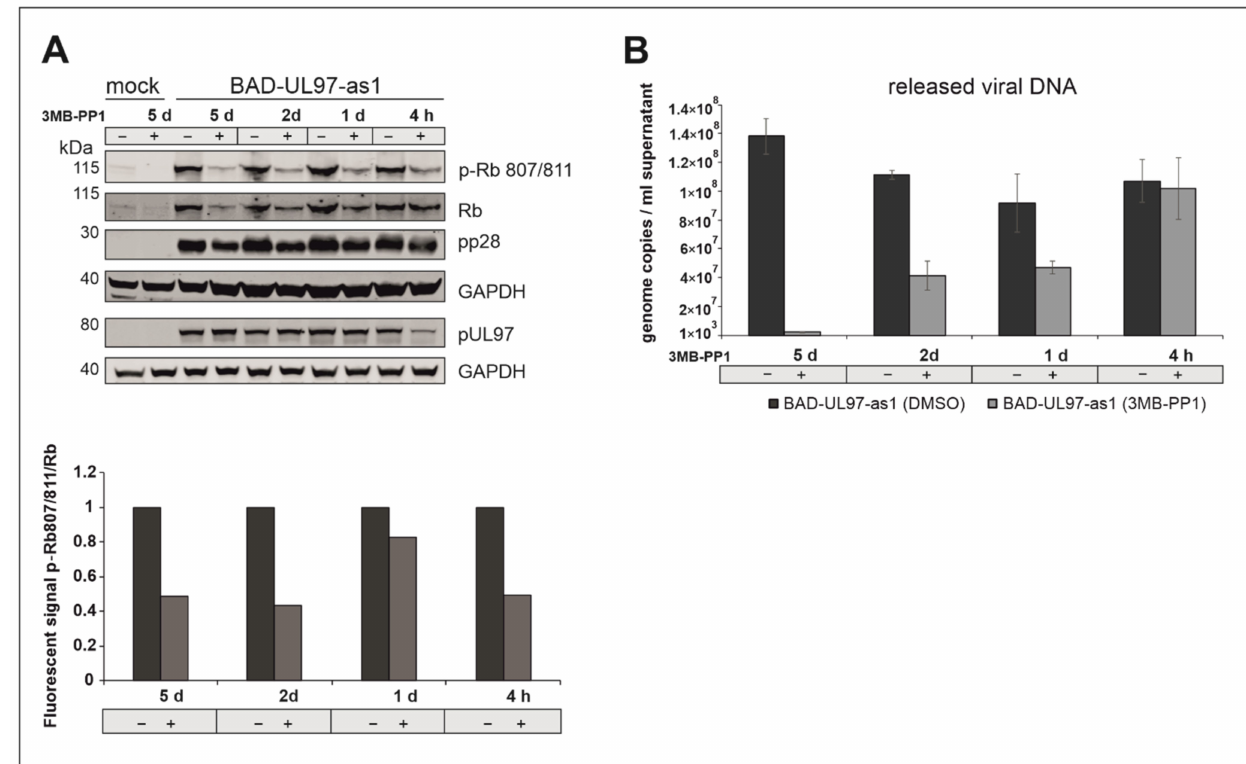
Figure 5. ( A ) BAD-UL97-as1 infected cells (10 genomes/cell) were harvested at 5 d.p.i. 40 µ M of 3MB-PP1 was added at either 5 days, 2 days, 1 day or 4 h before harvest. The samples were analyzed by SDS-Page and Western blot analysis, using a specific antibody against the phosphosite 807/811 of Rb. The quantification was performed by measuring the protein intensity of pRb and Rb using Image Studio Lite Version 5.2.5. The ratios (pRb807/811/Rb) in dependence of 3MB-PP1 are shown. Thereby the corresponding DMSO sample was indicated as 1 (n = 2). ( B ) BAD-UL97-as1 (2 genomes/cell) infected HFFs were treated with 3MB-PP1 at different time points during infection. At 5 days, 2 days, 1 day or 4 h before harvest, the inhibitor was added. After 5 days post-infection, the supernatant was collected, DNA was isolated and the viral DNA of three technical replicates was quantified by TaqMan-PCR. The means ± standard deviations of each sample are